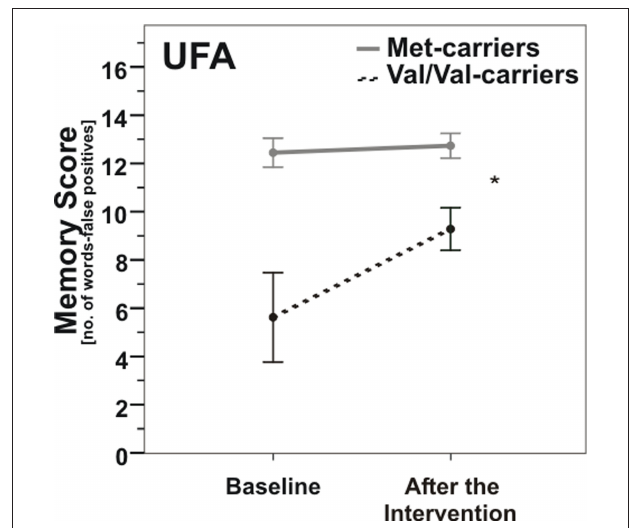
Figure 4 | Memory scores according to COMT Val 158 Met genotype pre- vs. post-enhancement of unsaturated fatty acids (uFA). Note that Val/ Val -carriers (dashed line) nearly reached baseline levels of carriers of at least one Met -allele (gray line) after UFA enhancement. *, p = 0.019; *, according to ANOVA . Error bars indicate standard error RM